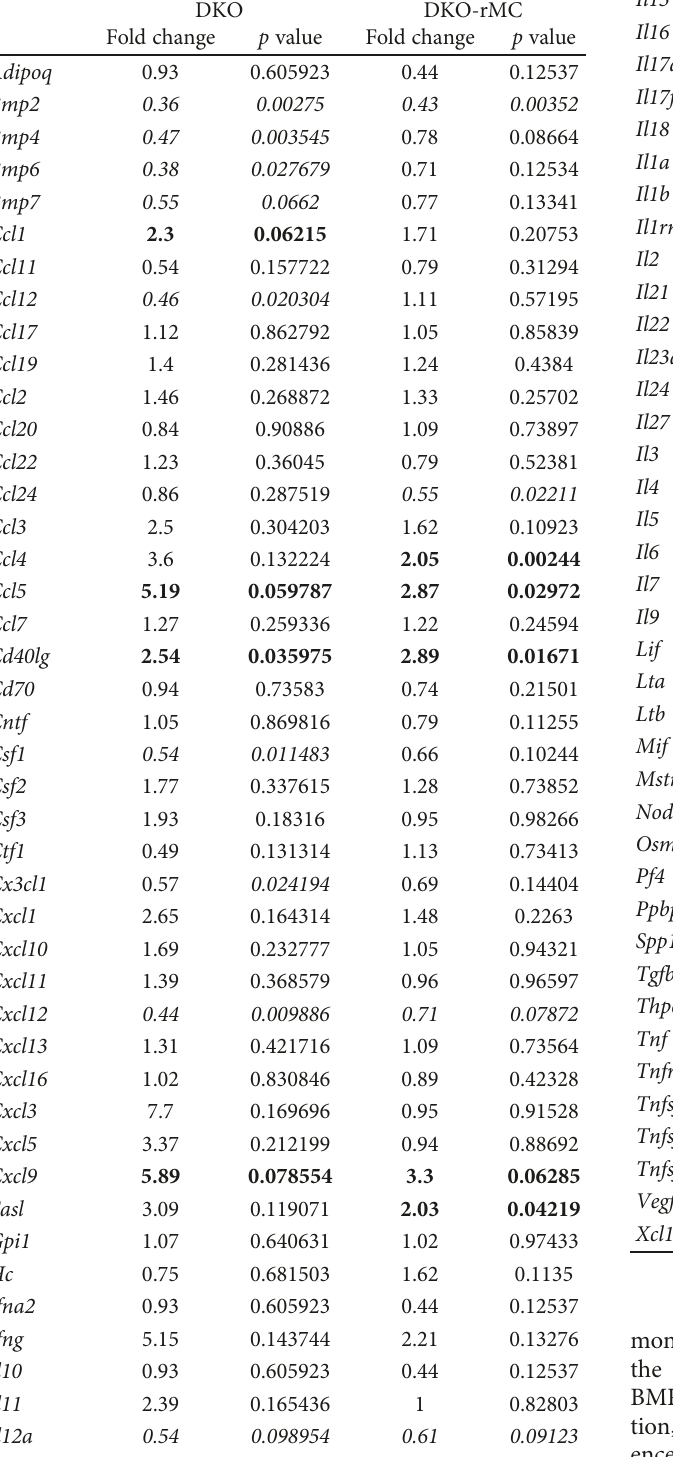
Table 1: Mast cell de fi ciency results in dysregulation of many di ff erent cytokines and chemokines. Fold change and p value of DKO and DKO-rMC mice compared to IL10 − / − . Signi fi cantly upregulated genes and downregulated genes indicated by bold and italic font, respectively ( p = ≤ 0 1